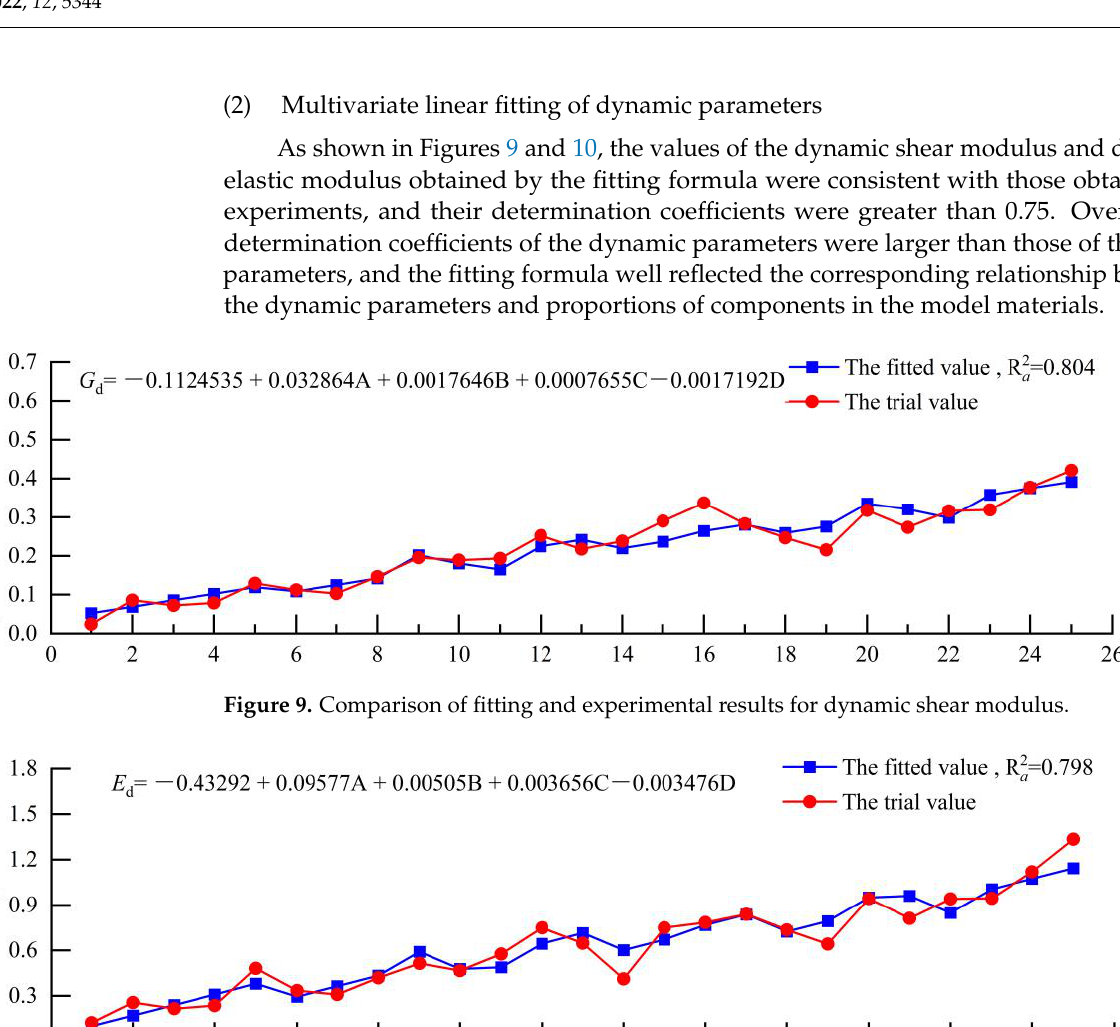
Figure 8. Comparison of fitted and experimental results for internal friction angle.